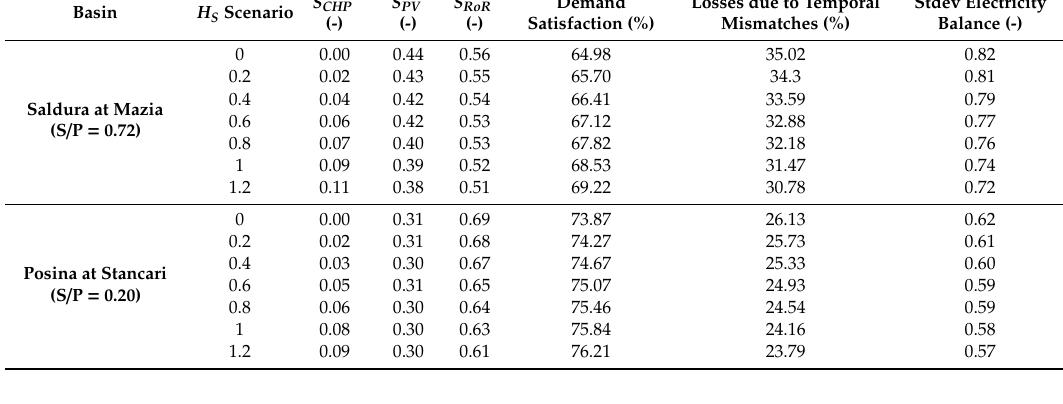
Posina at Stancari (S / P = 0.20)